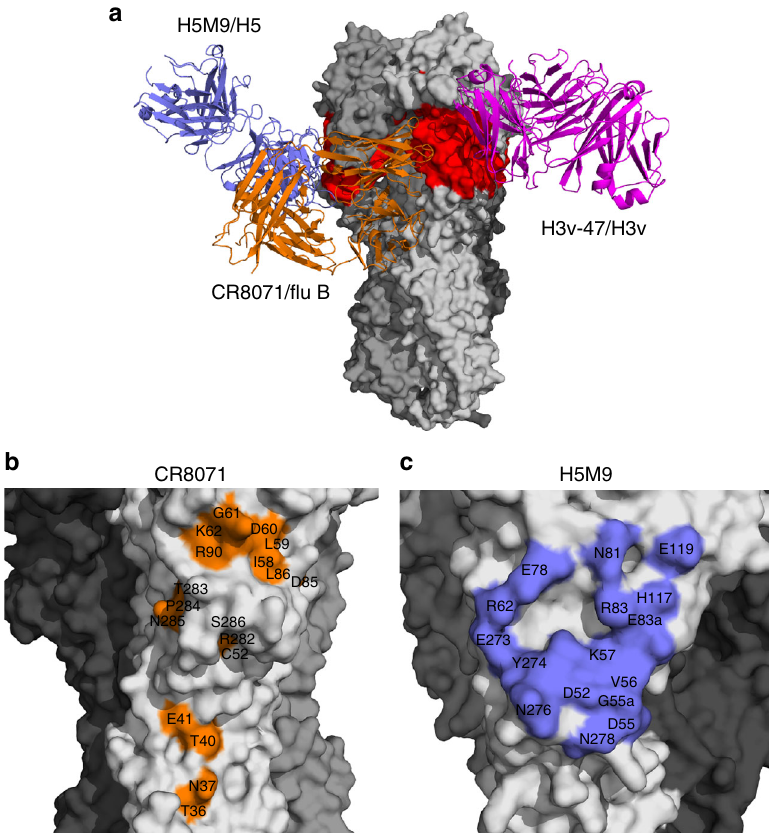
Fig. 8 Vestigial esterase subdomain-binding antibodies mediate neutralization by diverse mechanisms. a Comparison of H3v-47 (magenta) with structurally characterized esterase subdomain-binding antibodies, including H5M9 binding to H5 HA (PDB code 4MHH, blue) and CR8071 (PDB code 4FQJ, orange) binding to in fl uenza B HA. The HAs from all these complexes are aligned, and only the three protomers of A/Minnesota/11/2010 H3N2v HA trimer are shown as surface in light, middle or dark gray, respectively. The HAs from all these HA-antibody complexes are aligned. The vestigial esterase subdomain is highlighted in red. These antibodies target the HA vestigial esterase subdomain using different angles of approach. b - c The epitopes of CR8071 ( b ) and H5M9 ( c ) are mapped onto the surfaces of the corresponding